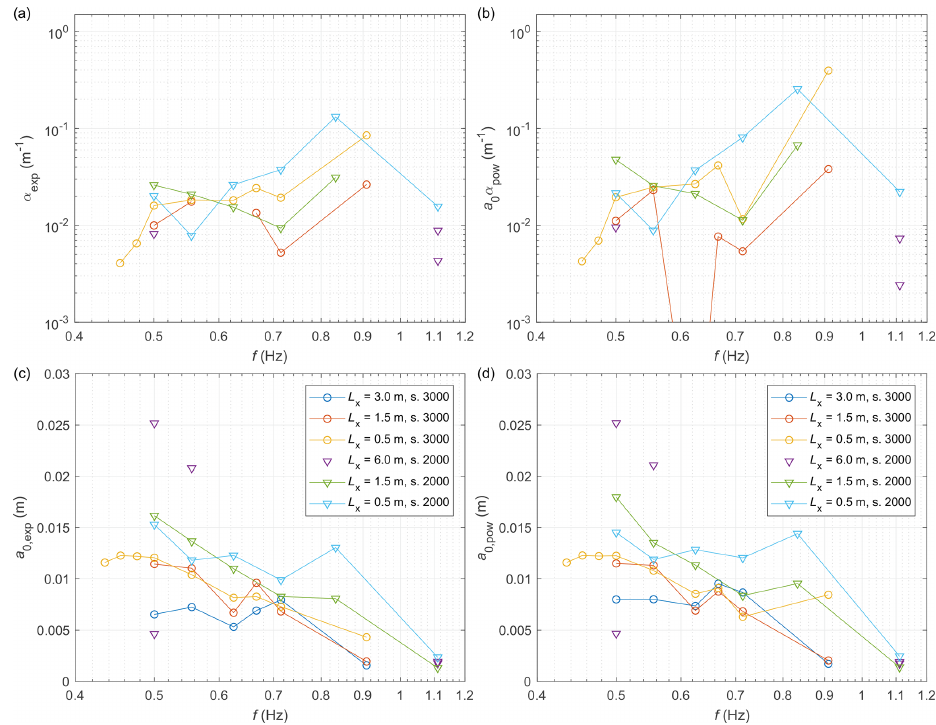
Figure 5. Attenuation rates (m − 1 ; a, b ) and a 0 (m; c, d ) in function of wave frequency f (Hz) obtained by fitting Eq. (4) (a, c) and Eq. (5) (b, d) to the observed LS-WICE data, with a 0 being treated as a fitted coefficient. Note that in some tests (e.g. series 3000 with L x = 3 . 0m) the fitted values of α are negative and therefore are not shown in panels (a and b) .